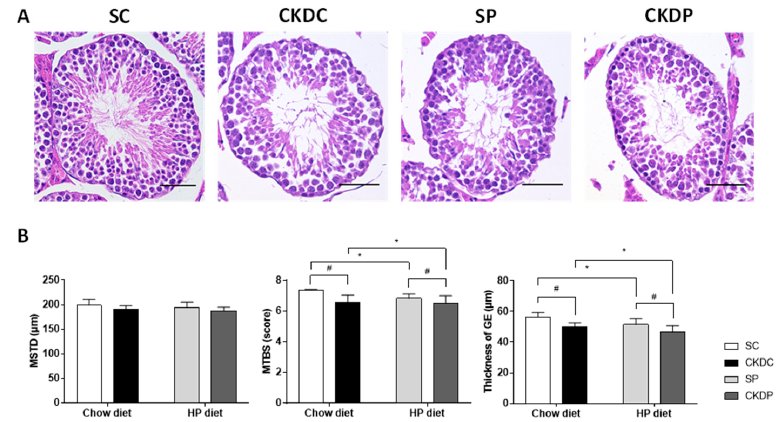
Figure 3. Testicular morphology and related parameters in high phosphorus diet-fed mice with or without CKD induction. ( A ) Testicular morphology, ( B ) mean seminiferous tubule diameter (MSTD), mean testicular biopsy score (MTBS) and thickness of the germinal epithelium (GE). Data are expressed as the mean ± SD. # indicates a significant di ff erence between the sham-operated and CKD-induced groups (SC vs. CKDC and SP vs. CKDP); * indicates a significant di ff erence between the chow diet and high phosphorus diet groups (SC vs. SP and CKDC vs.